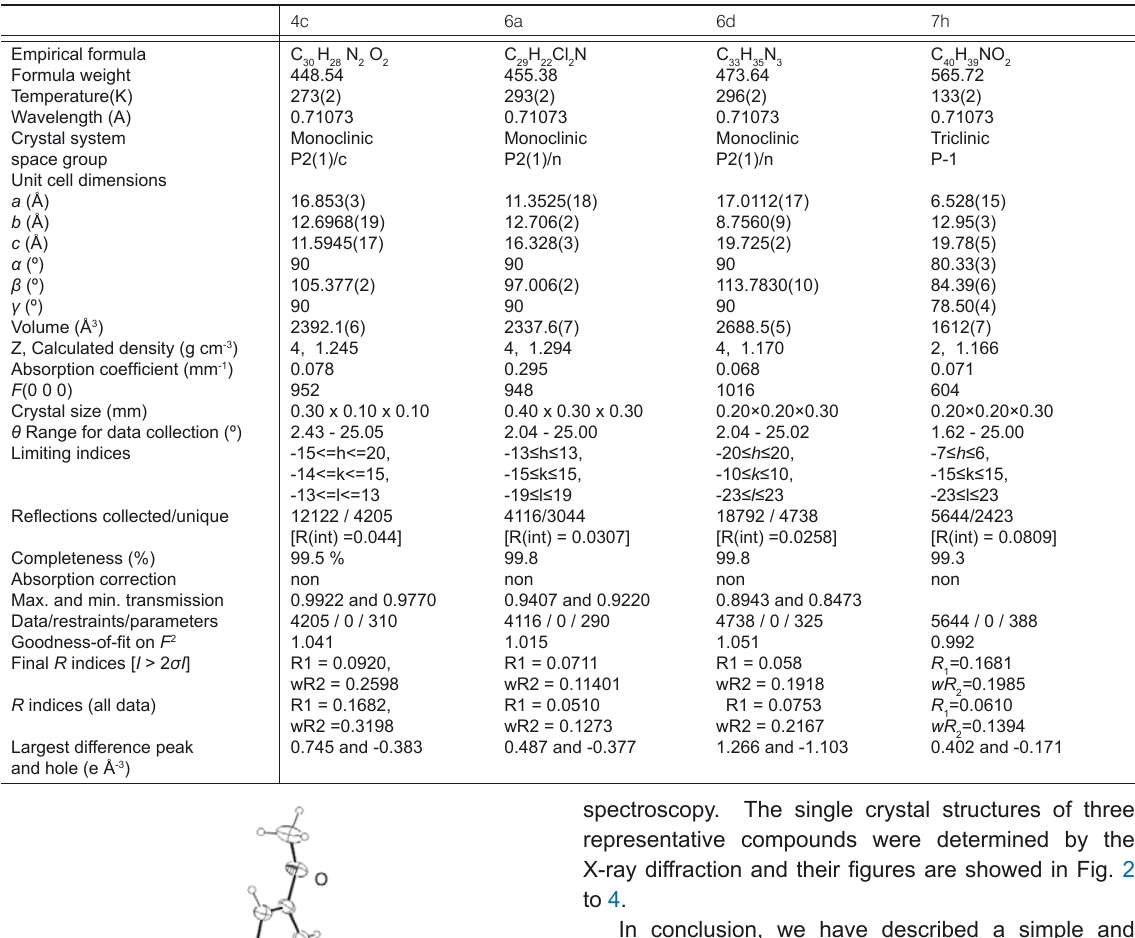
Table 3. Crystal data and structure refinement of the compounds.